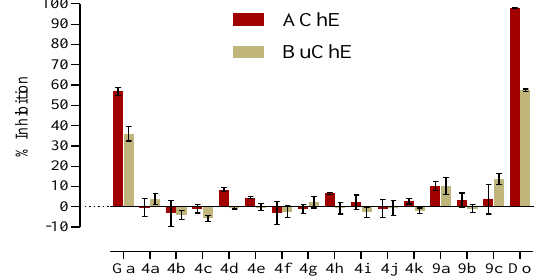
Figure 5. Respective enzyme inhibitions upon exposure to test and reference compounds (galantamine or Ga and Do ). All compounds were tested at 2 µM (AChE) using 0.02 U/mL enzyme or Ga and Do ). All compounds were tested at 2 µ M (AChE) using 0.02 U/mL enzyme quantities. quantities. Data are expressed as means of the % AChE inhibition ± SD, n = 3. BuChE: Data are expressed as means of the % AChE inhibition ± SD, n = 3. BuChE: butyrylcholinesterase.